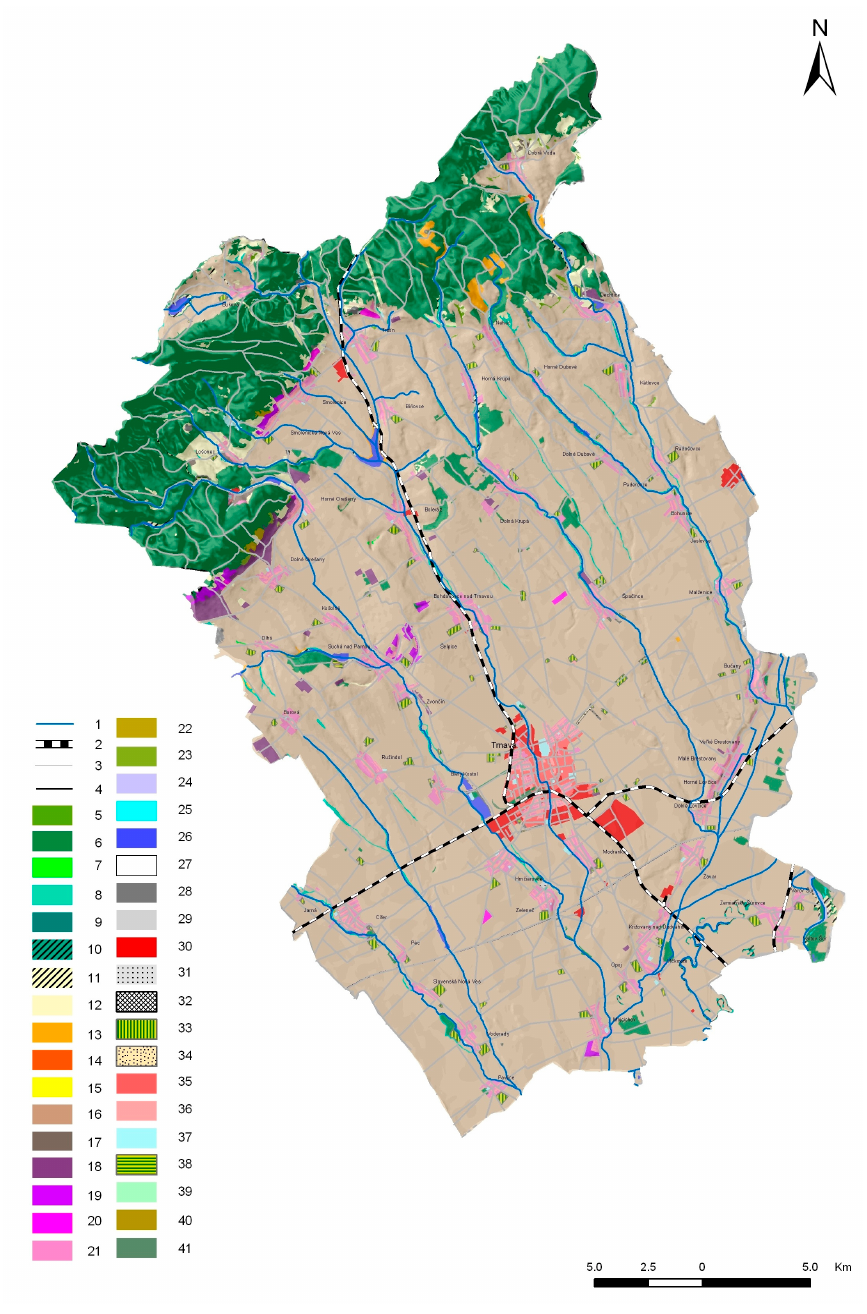
Figure 3. Land use of the study area. Legend: 1. Water flows; 2. Railways; 3. Roads; 4. Highways; 5. Forests; 6. Semi-natural small woodland; 7. Planted small woodland; 8. Riparian vegetation; 9. Lines of trees or shrubs; 10. Wetlands; 11. Wet meadows; 12. Extensively managed grasslands; 13. Intensively managed meadows; 14. Intensively managed pastures; 15. Dry grasslands; 16. Large-block arable land; 17. Small arable fields; 18. Large-block vineyards; 19. Small-block vineyards; 20. Orchards; 21. Gardens; 22. Mosaic of arable lands and grasslands; 23. Wooded grasslands; 24. Natural water body; 25. Channels; 26. Water reservoirs; 27. Rocks; 28. Abandoned fields; 29. Brown fields; 30. Industrial areas; 31. Mining areas; 32. Industrial pond; 33. Agricultural farms; 34. Field airport; 35. Urban areas; 36. Rural settlement; 37. Recreational zone; 38. Garden zones with cottages; 39. Cottages; 40. Abandoned areas; 41. Transport areas.